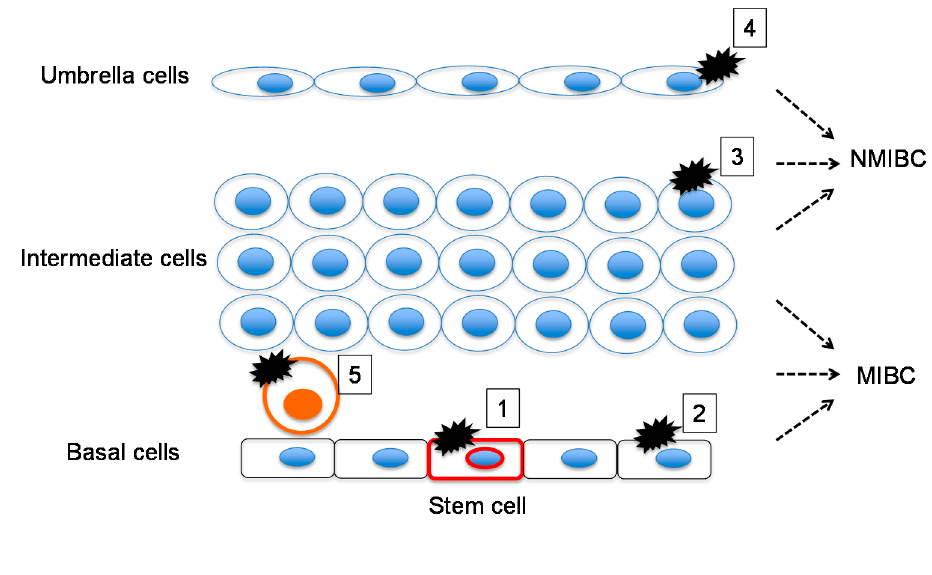
Figure 2. Normal bladder tissue may be a possible origin of bladder CSCs by direct transformation into CSCs via mutations in urothelial stem cells, basal cells, intermediate cells, and terminally differentiated umbrella cells. Urothelial stem cells, basal cells and intermediate cells give rise to muscle-invasive bladder cancer (MIBC), whereas umbrella and intermediate cells give rise to non-muscle-invasive bladder cancer (NMIBC).